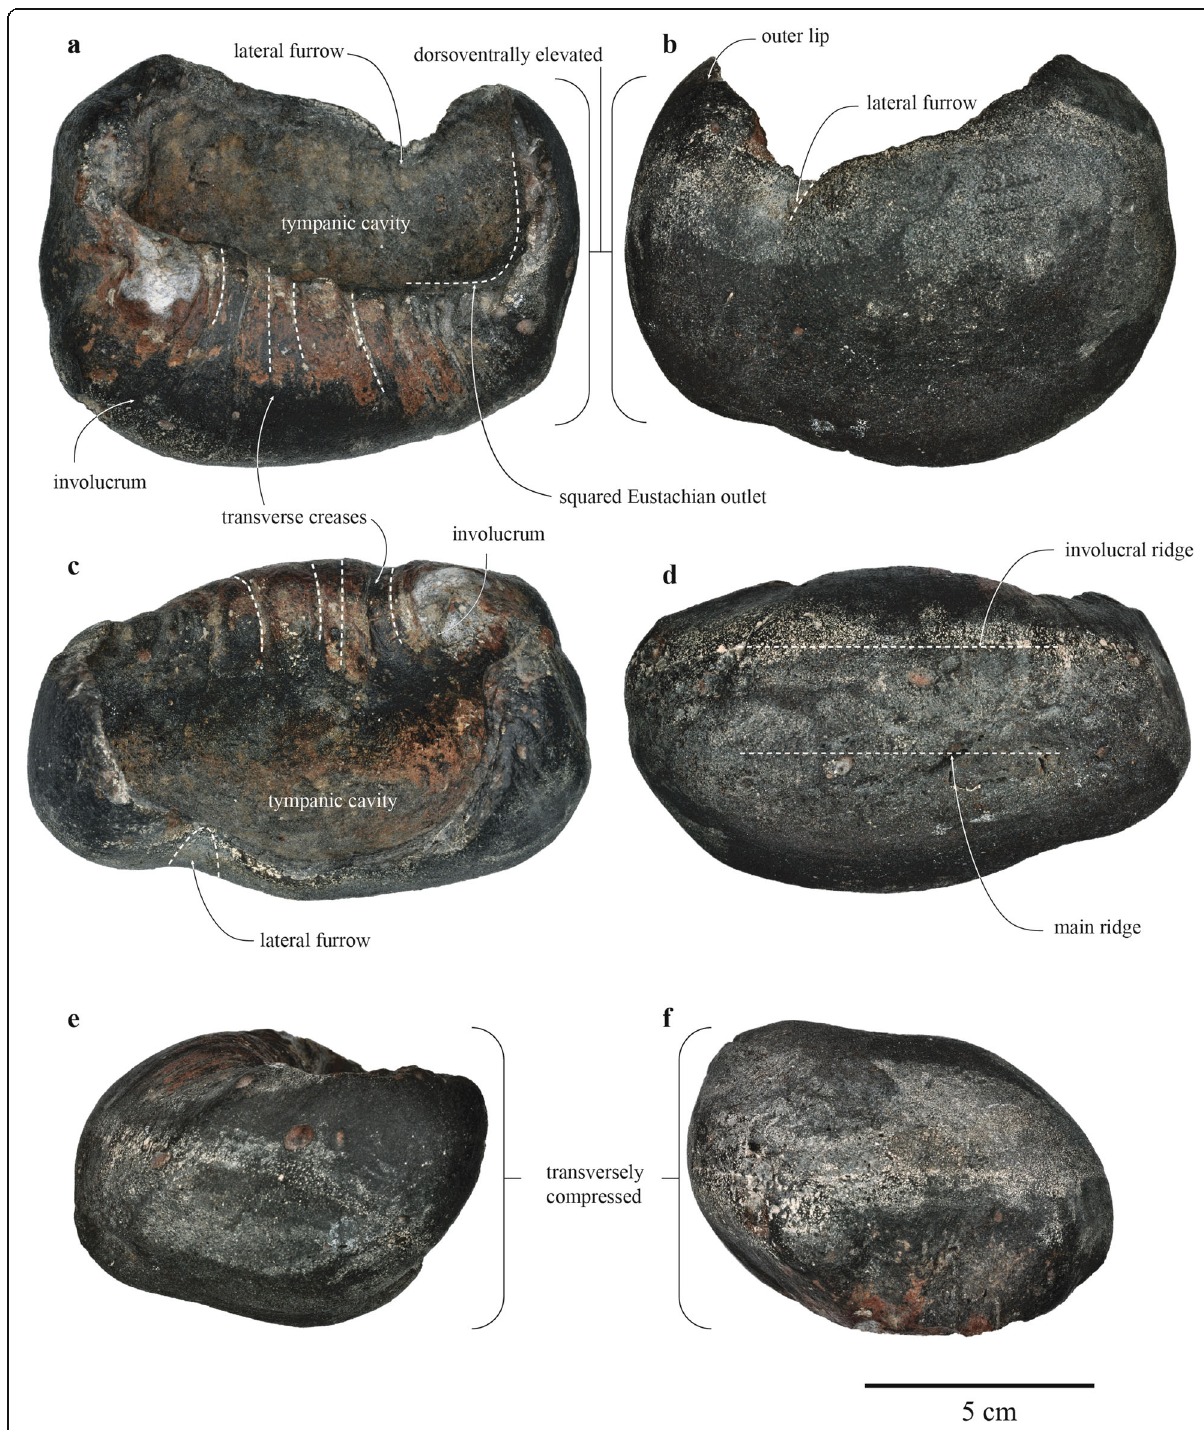
Fig. 2 Left tympanic bulla of the Pleistocene Eubalaena sp., NTUM-VP 190807. a medial view; b lateral view; c dorsal view; d ventral view; e anterior view; f posterior